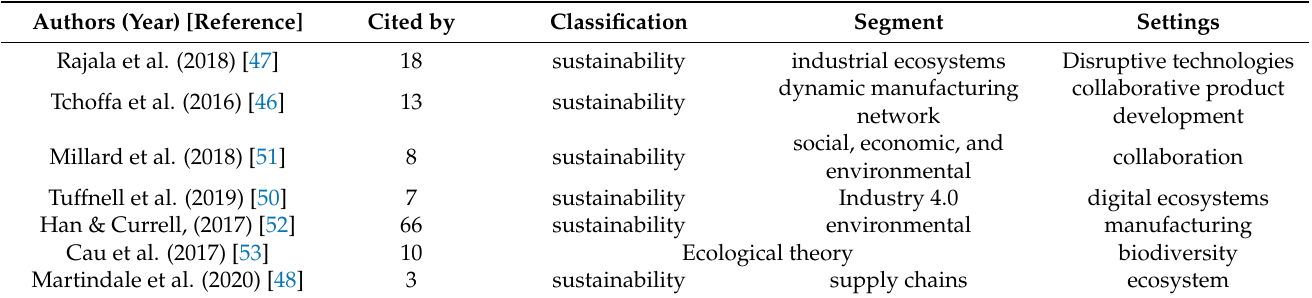
Table 5. Distribution of author, citations, and classifications from